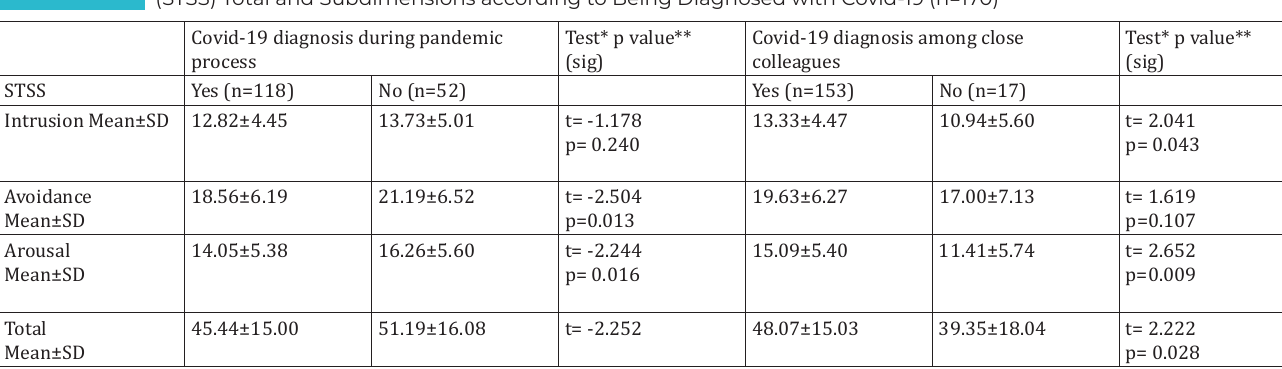
* T test in independent groups ** p<0.05